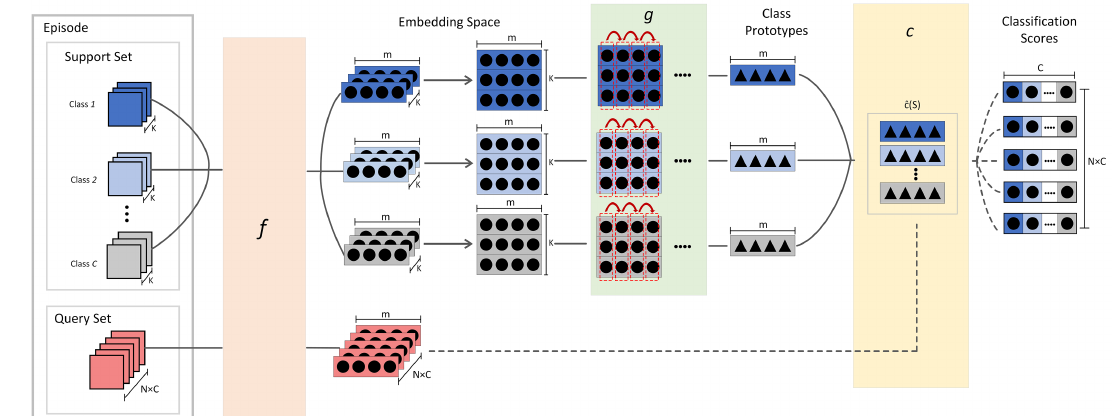
Figure 3. Overall architecture of